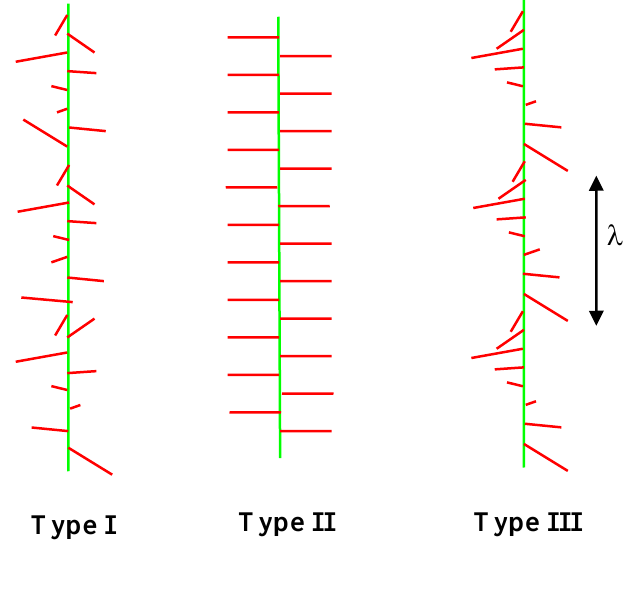
Figure 4. Electrostatic modulation of the morphologies of the side-chains of charged comb polyelectrolytes. λ is the wavelength of the helical modulation (the pitch). Relatively rigid side-chains are shown, but similar instabilities are possible with flexible polyelectrolyte combs. Three types of side-chain morphology are shown, Type I ( random ), Type II ( alternating ) and Type III ( helical